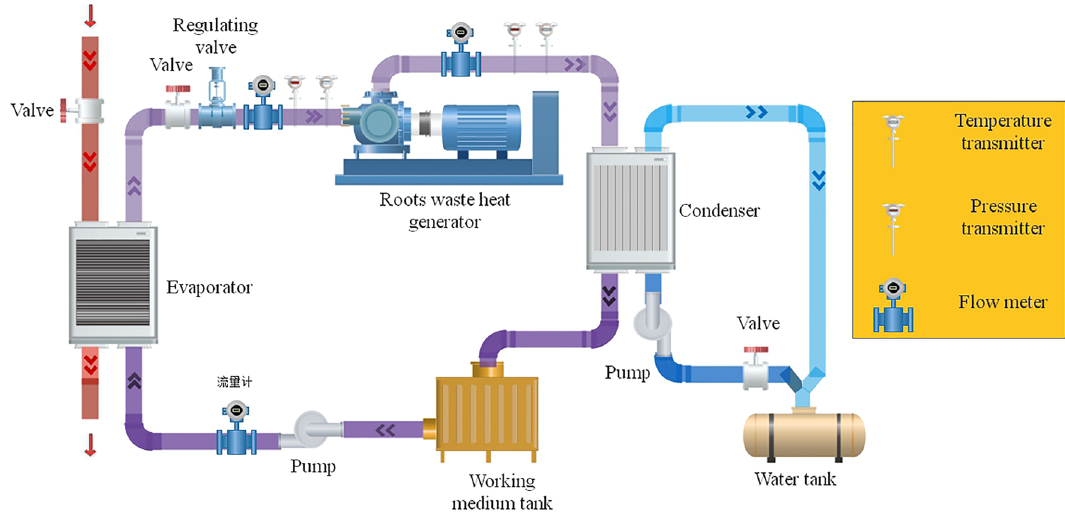
Figure 3. Roots waste heat recovery power generation